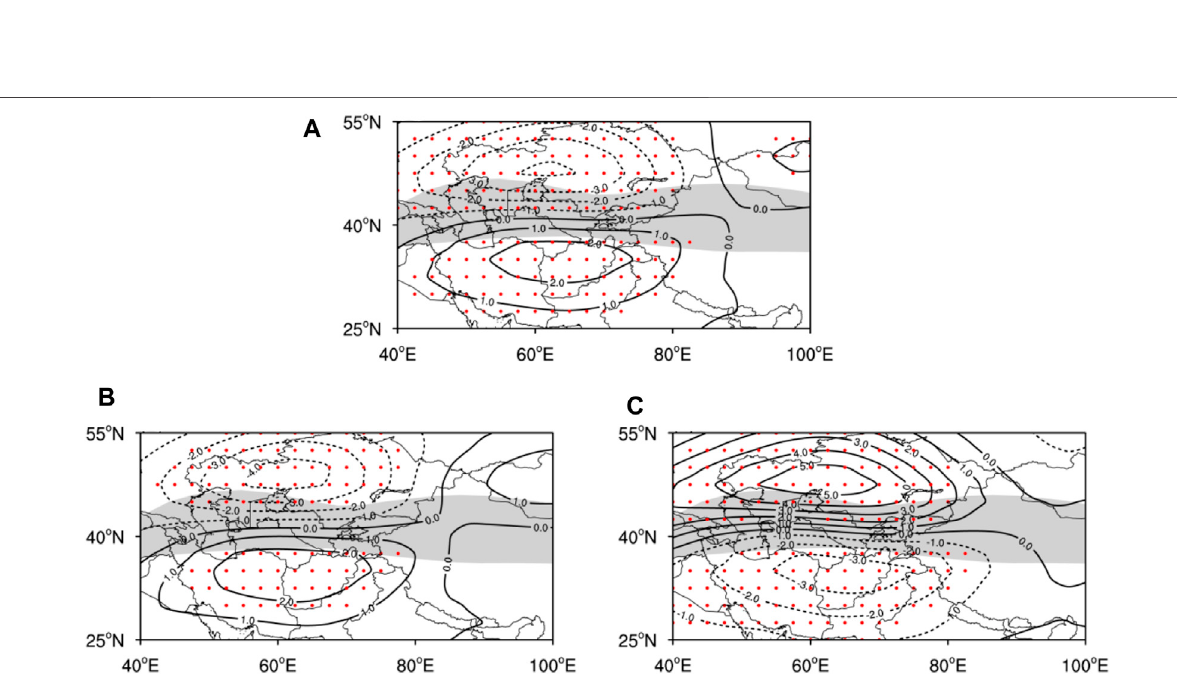
Frontiers in Earth Science |